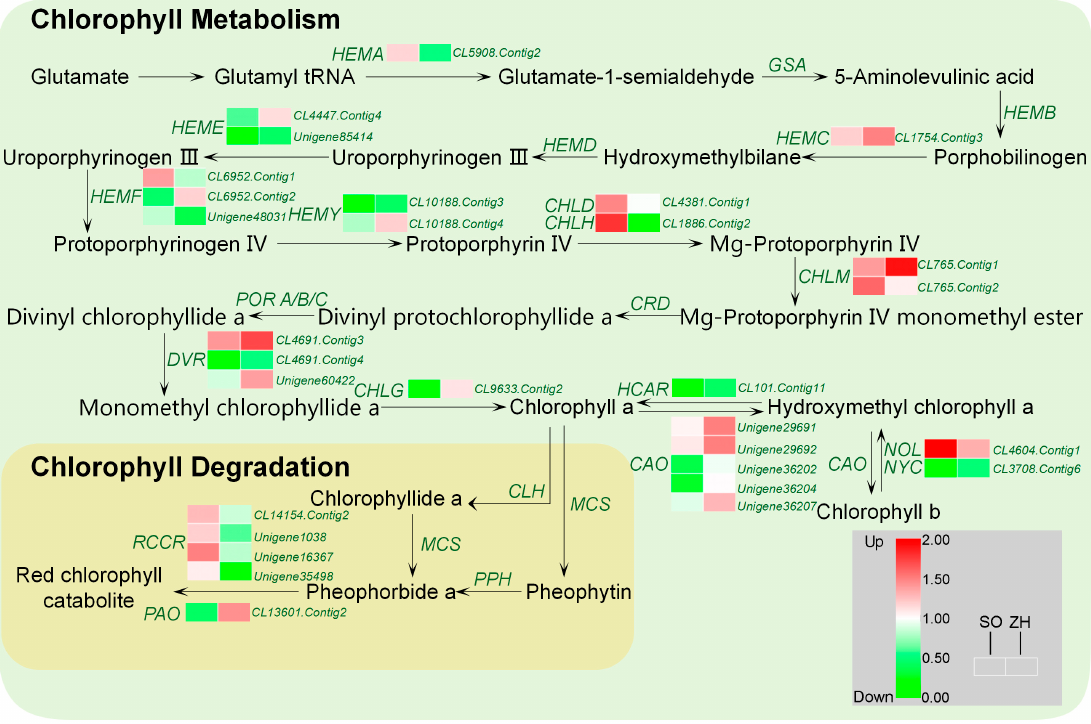
Figure 10. Expression profiles of DEGs involved in chlorophyll biosynthesis and degradation between ‘SO’ and ‘ZH’.